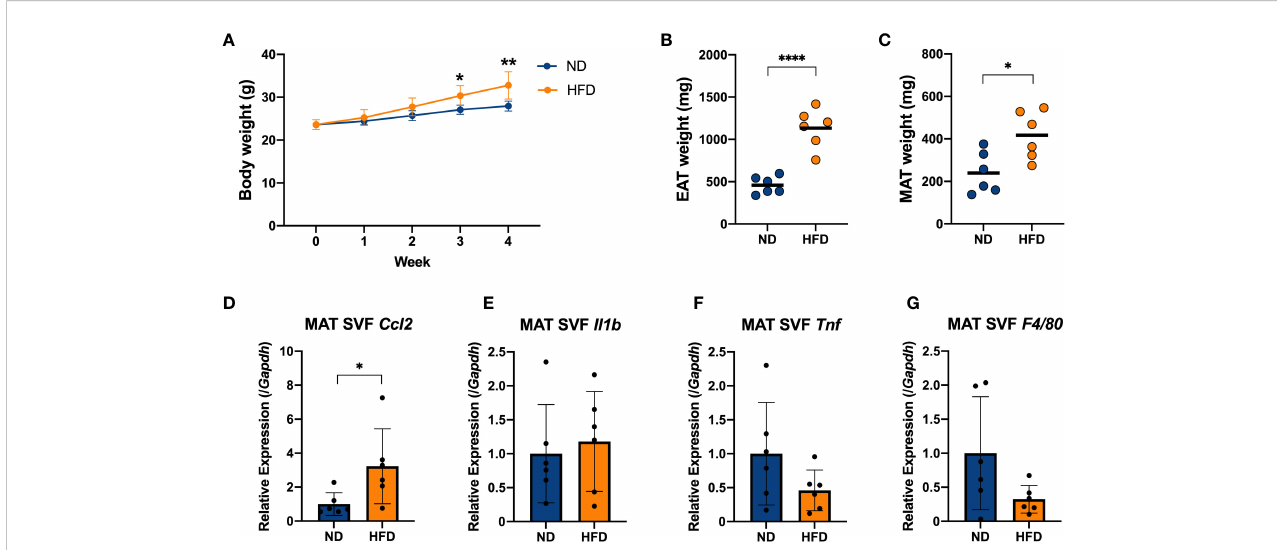
FIGURE 3 Four weeks of intake of a high-fat diet caused in fl ammation in the stromal vascular fraction (SVF) cells derived from adipose tissue of mice. C57BL/6N male mice were fed a HFD (60% kcal from fat) for 4 weeks from 8 weeks of age. Mice fed a standard chow diet (AIN-93 M) were used as a control group. (A) Mice were weighed once per week. The weights of the epididymal adipose tissue (EAT) (B) and mesenteric adipose tissue (MAT) (C) were measured after 4 weeks on a HFD and compared with the ND group. The stromal vascular fraction (SVF) cells were isolated from the MAT (D – G) . The mRNA expression of CCL2 ( Ccl2 ), IL-1 b ( Il1b ), TNF ( Tnf ) and F4/80 ( F4/80 ) was measured by qPCR. The results are representative of two independent experiments and are shown as the mean ± standard deviation (n = 6). * p <0.05; ** p <0.01; **** p <0.0001 (assessed using Student ’ s t -test). ND, normal diet; HFD, high-fat diet; EAT, epididymal adipose tissue; MAT, mesenteric adipose tissue; SVF, stromal vascular